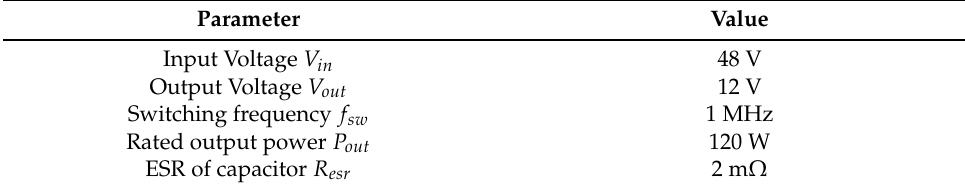
Figure 7. ( a ) Model for parallel simulation in Matlab and ( b ) the dataset for the CNN model. Table 2. Simulation Parameters.